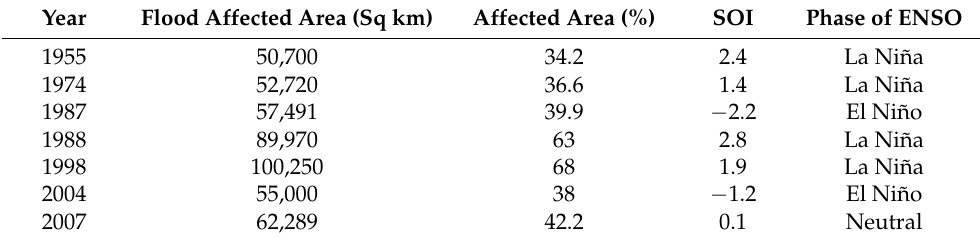
Table 2. Categorizing the major floods in Bangladesh on ENSO timescales.